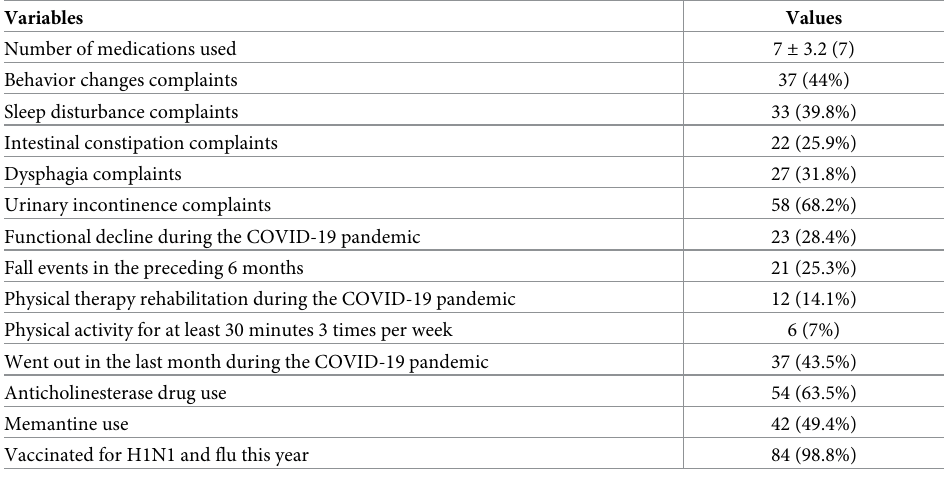
Table 3. Medical conditions of the study participants. Variables Values Number of medications used 7 ± 3.2 (7) Behavior changes complaints 37 (44%) Intestinal constipation complaints Dysphagia complaints Urinary incontinence complaints